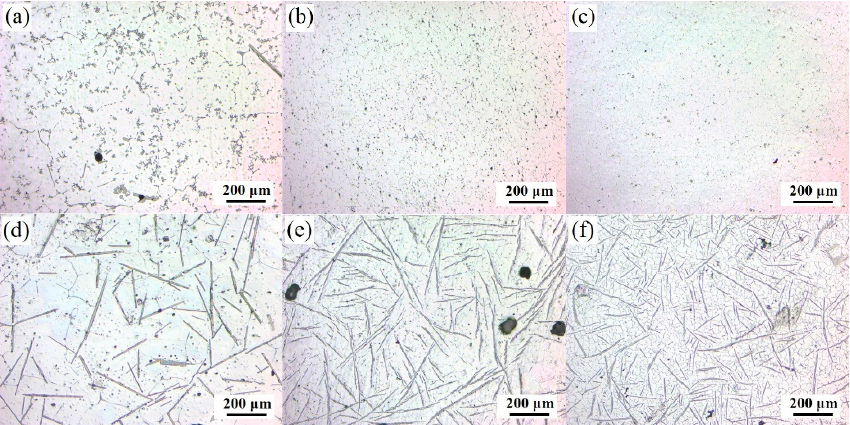
Figure 5. OM images of remelted Al-5Zr master alloy at different remelting conditions: ( a ) cooling rate of 1.6 °C /s, ( b ) cooling rate of 18.7 °C /s, ( c ) cooling rate of 28.6 °C /s, ( a – c ) remelting temperature of 920 °C , ( d ) cooling rate of 1.5 °C /s, ( e ) cooling rate of 19.4 °C /s, ( f ) cooling rate of 25.3 °C /s, and ( d – f ) remelting temperature of 1320 °C .